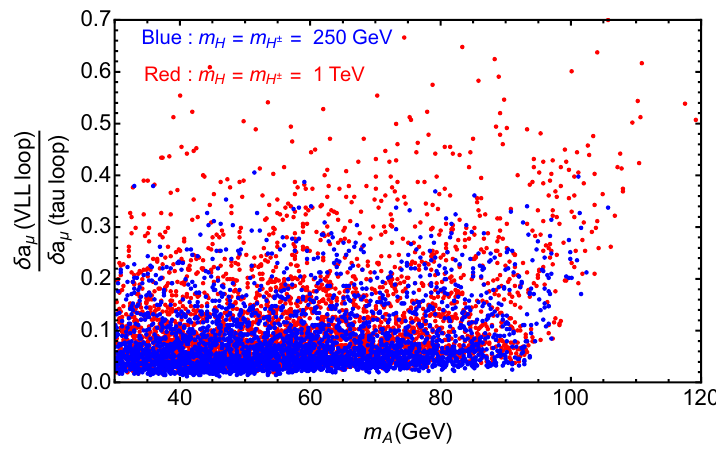
Figure 5 . Ratio of the Barr-Zee diagram contribution with VLL and τ in the loop towards muon ( g − 2) as a function of pseudo-scalar